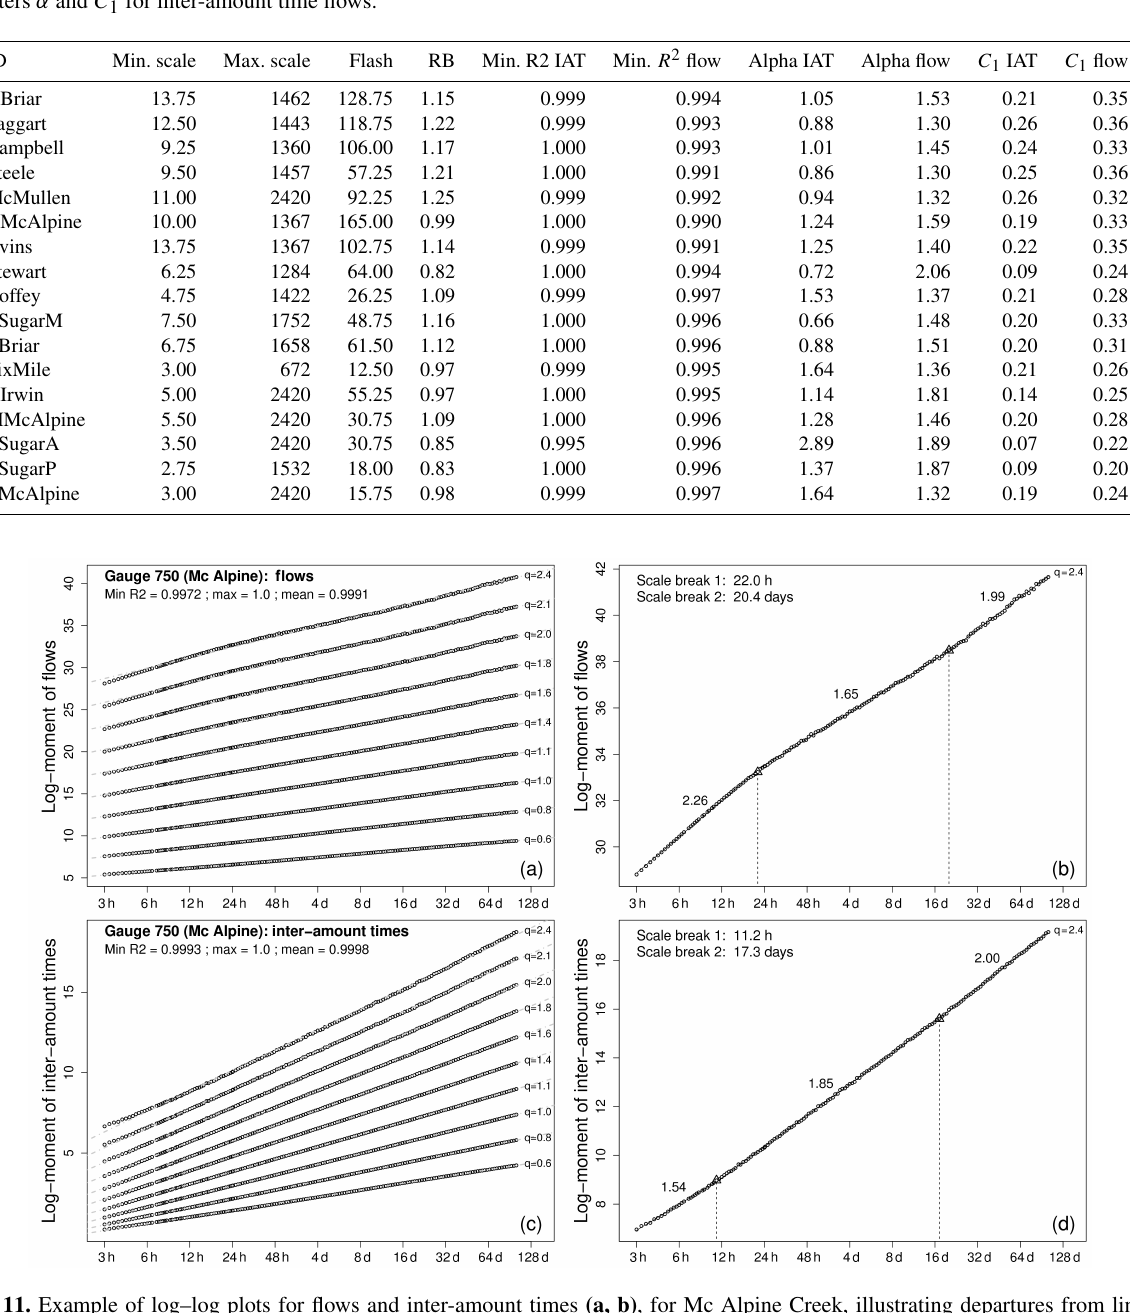
Table 5. Minimum and maximum observable scales (in hours), flashiness index for 15min observation time (in hours) and fitted multifractal parameters α and C 1 for inter-amount time flows.